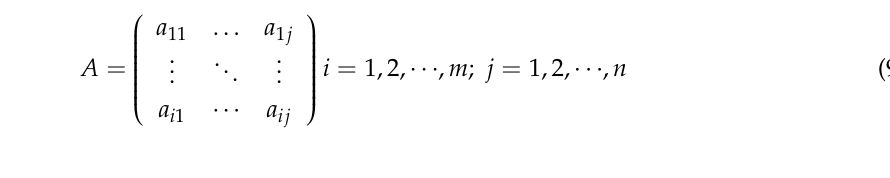
Table 1. The definition and explanation of the evaluation